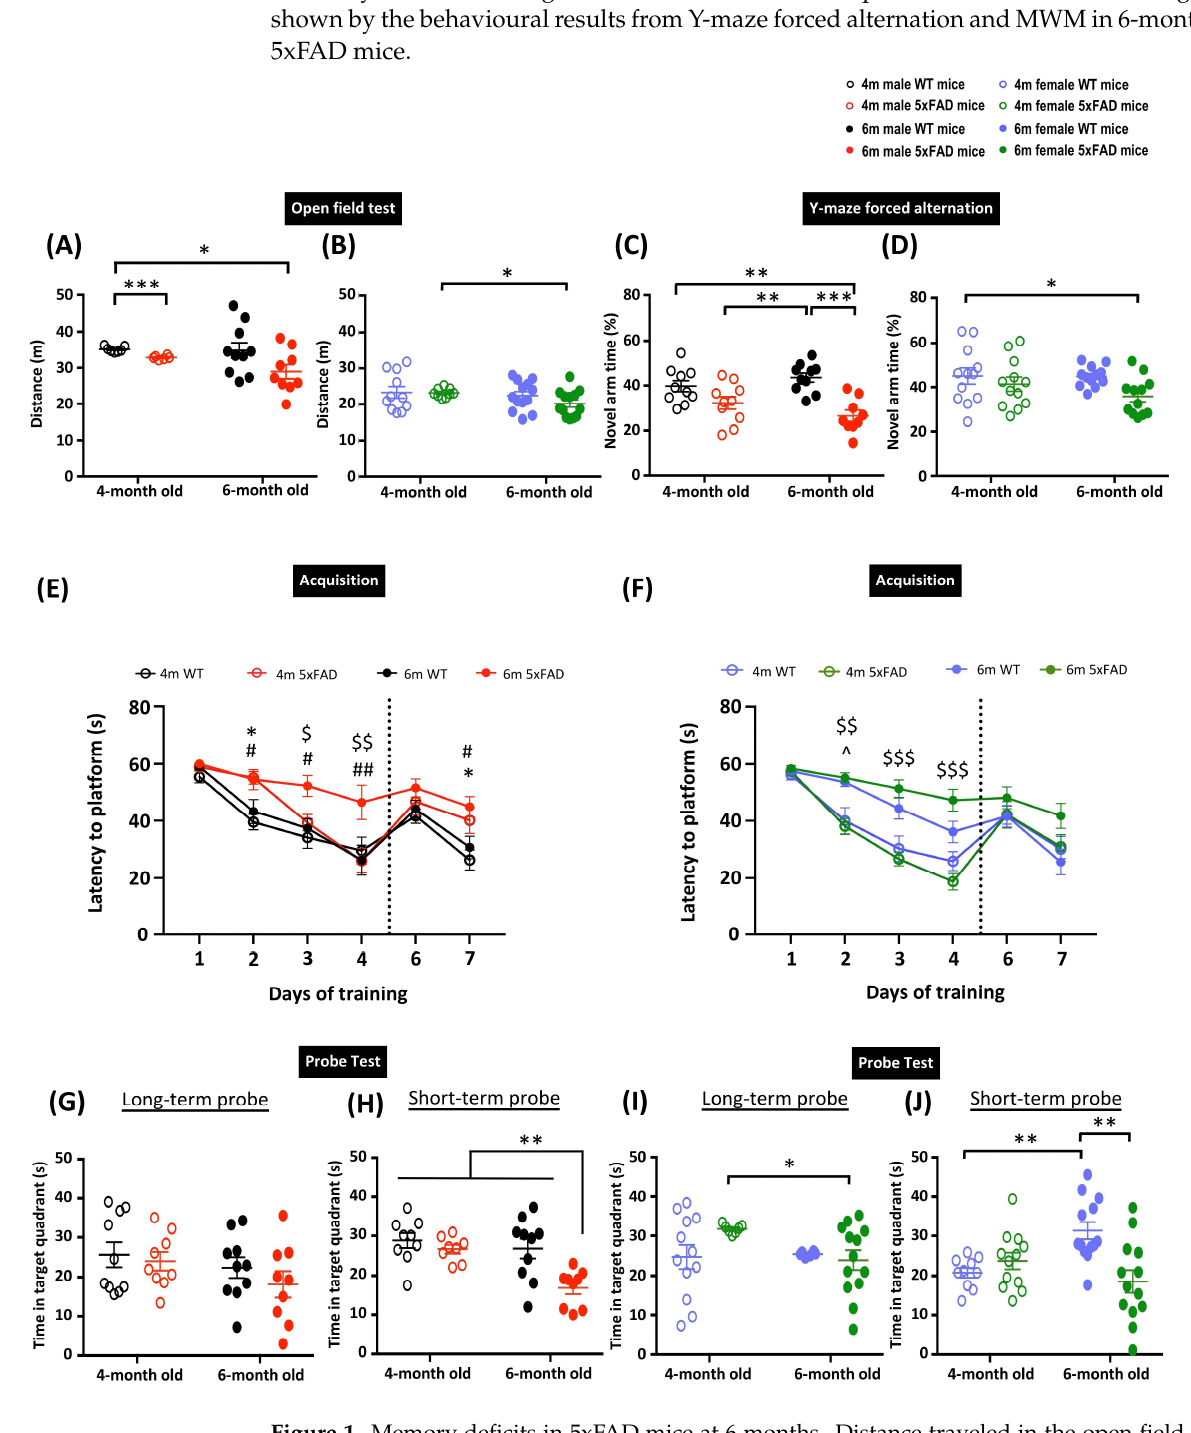
Figure 1. Memory deficits in 5xFAD mice at 6 months. Distance traveled in the open field test in ( A ) male and ( B ) female 5xFAD mice. Percentage of time spent in the novel arm in Y-maze forced alter- nation in ( C ) male and ( D ) female 5xFAD mice. Learning performance during the acquisition phase of the Morris water maze by the latency to locate the hidden platform in ( E ) male and ( F ) female 5xFAD mice. Reversal learning with the platform moved to the opposite quadrant was assessed on days 6–7. Time spent in the target quadrant during the long- and short-term probe in ( G , H ) male and ( I , J ) female 5xFAD mice. Data presented as mean ± S.E.M. Scatterplot shows individual value; * denotes comparison between 4-months old WT and 4-months old 5xFAD mice, ^ denotes compar- ison between 4-months old and 6-months old WT mice, $ denotes comparison between 4-months